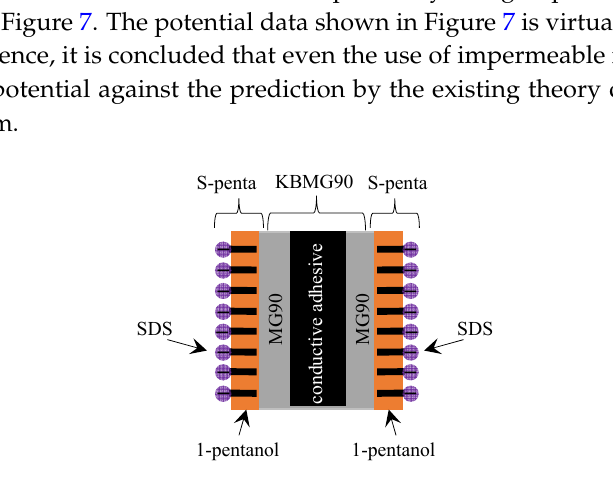
Figure 6. Side view of SKBMG90 coated with S-penta.